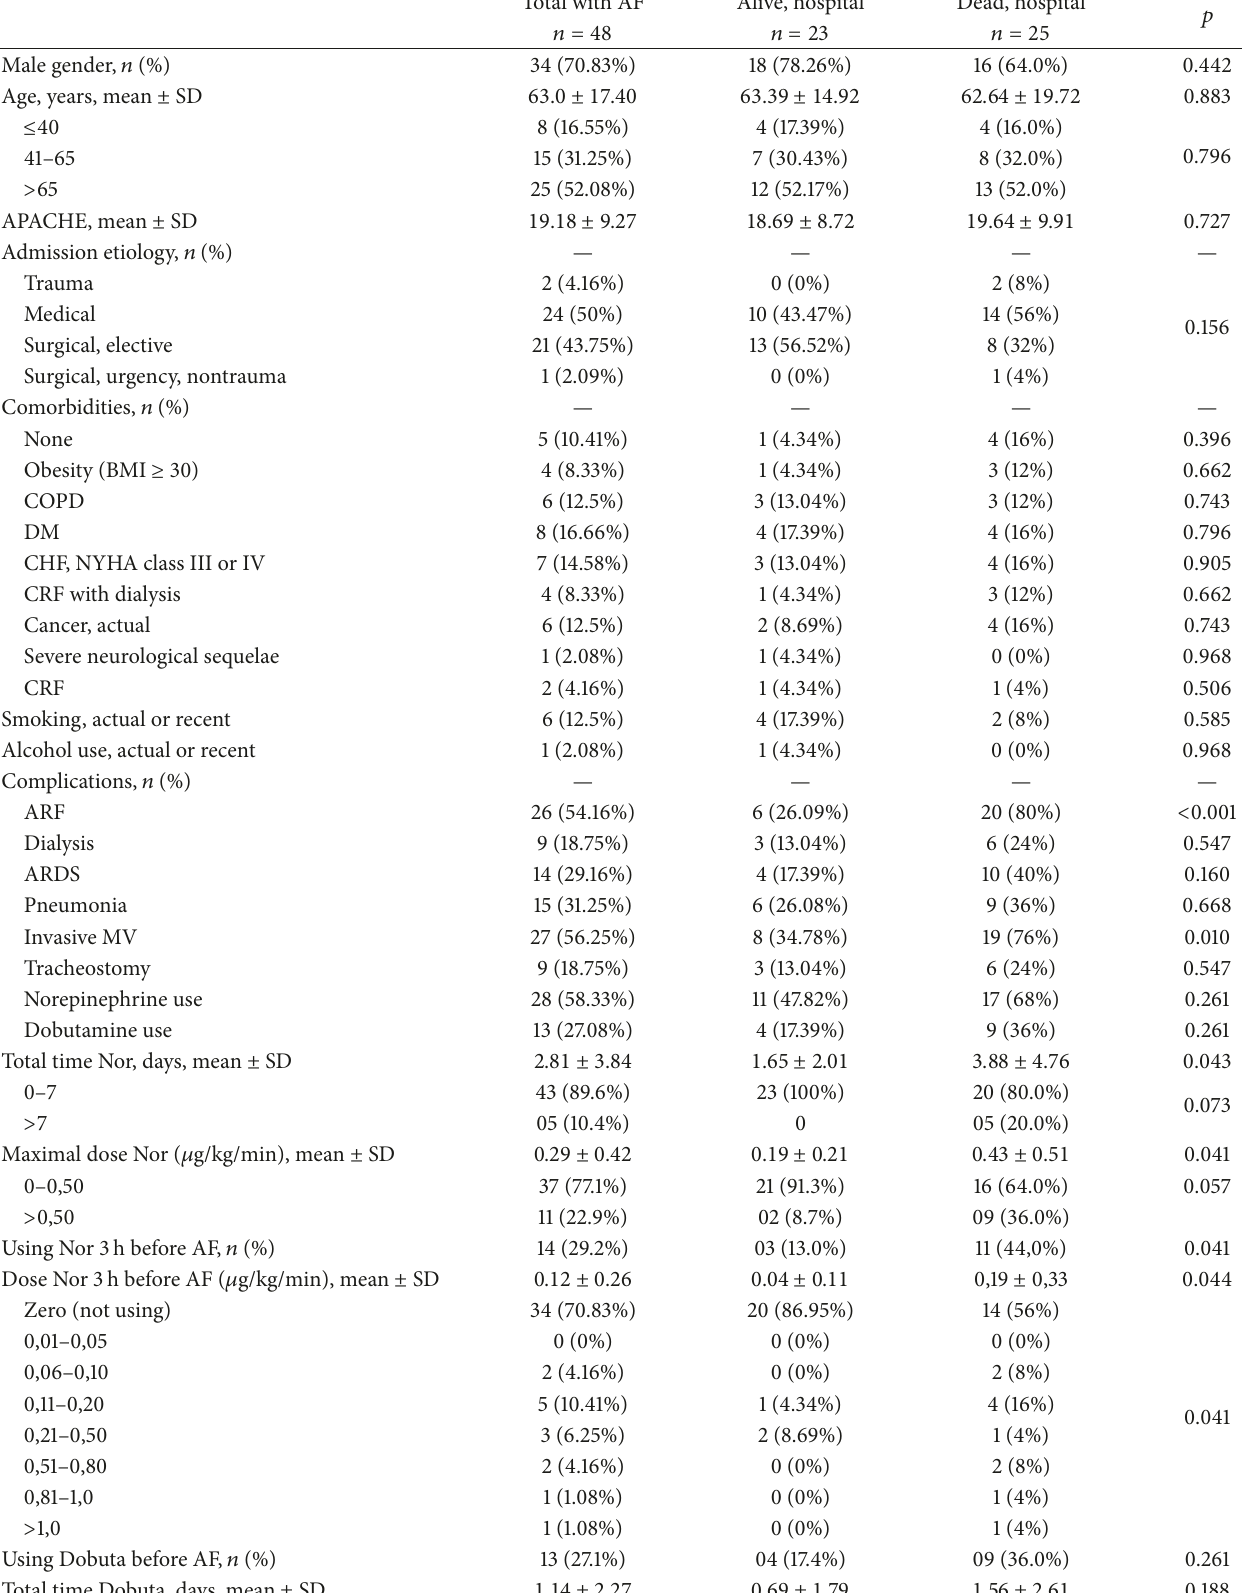
Table 2: Patients with AF: risk factors for hospital